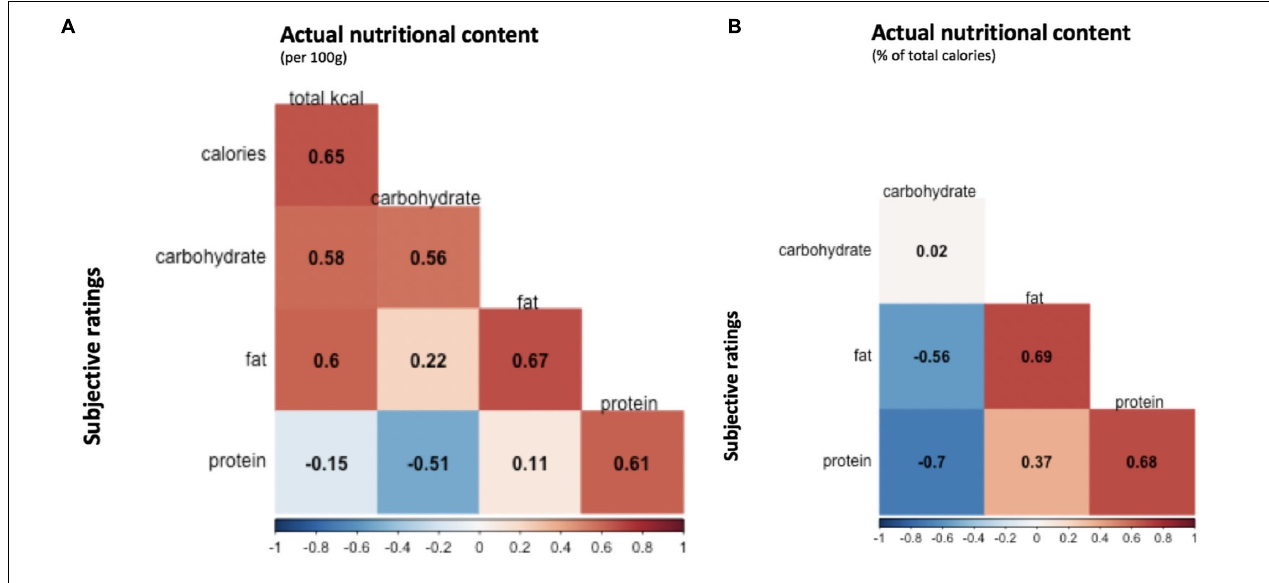
FIGURE 6 | Average correlations between subjective ratings and actual nutritional content. Correlations between average participant ratings for calorie, carbohydrate, fat and protein content, and actual nutrient content values were estimated across the 138 food items. (A) Pearson correlation coefficients reflecting the association between participant ratings of nutrient content and actual calorie/macronutrient content per 100 g. (B) Pearson correlation coefficients reflecting the association between participant ratings of nutrient content and actual macronutrient content as a percentage of total